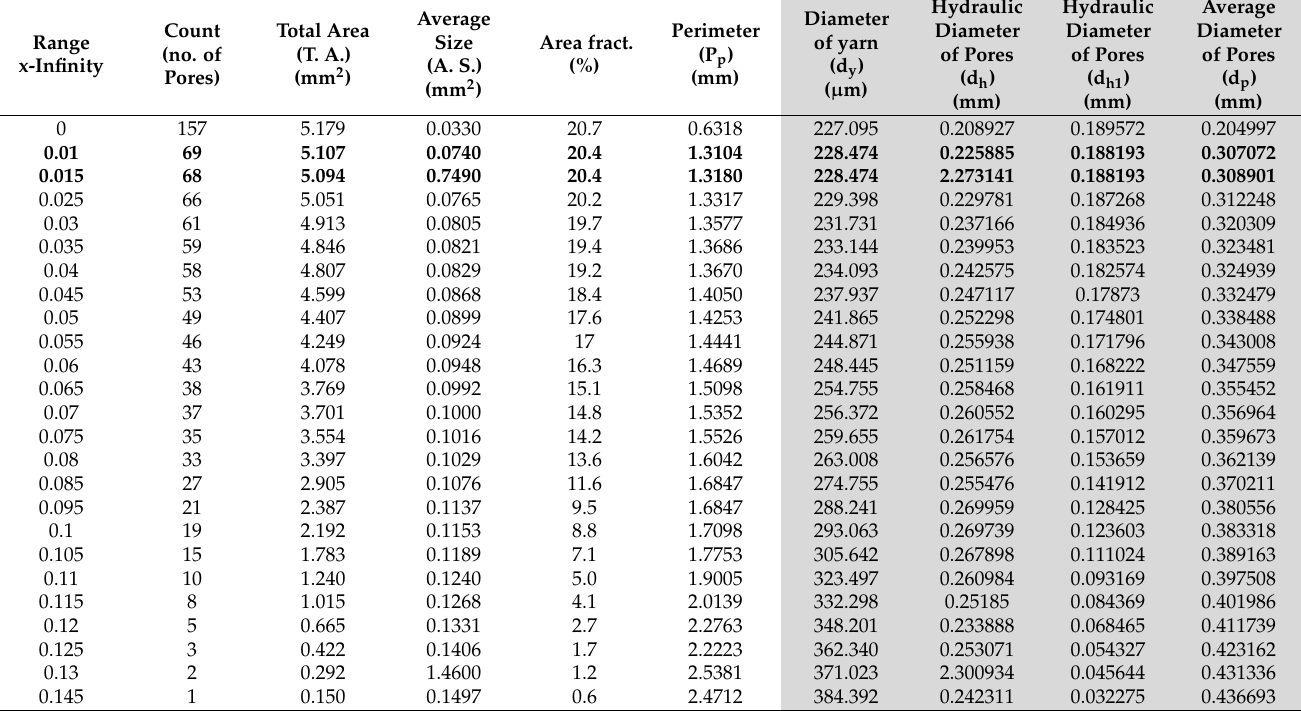
Table 5. ImageJ processed measurements and basic calculation for warp rib